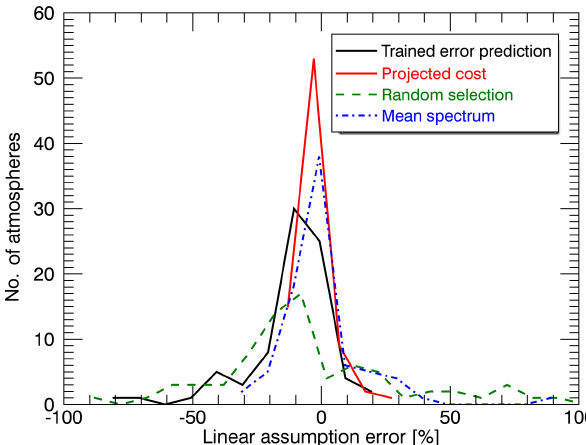
Figure 9. Histograms of the OCS retrieval error due to non- linearities are shown for four methods of selecting the initial at- mosphere, x 0 . The first enumerated method in this section is la- beled “mean spectrum”, the second “projected cost”, and the third “trained error